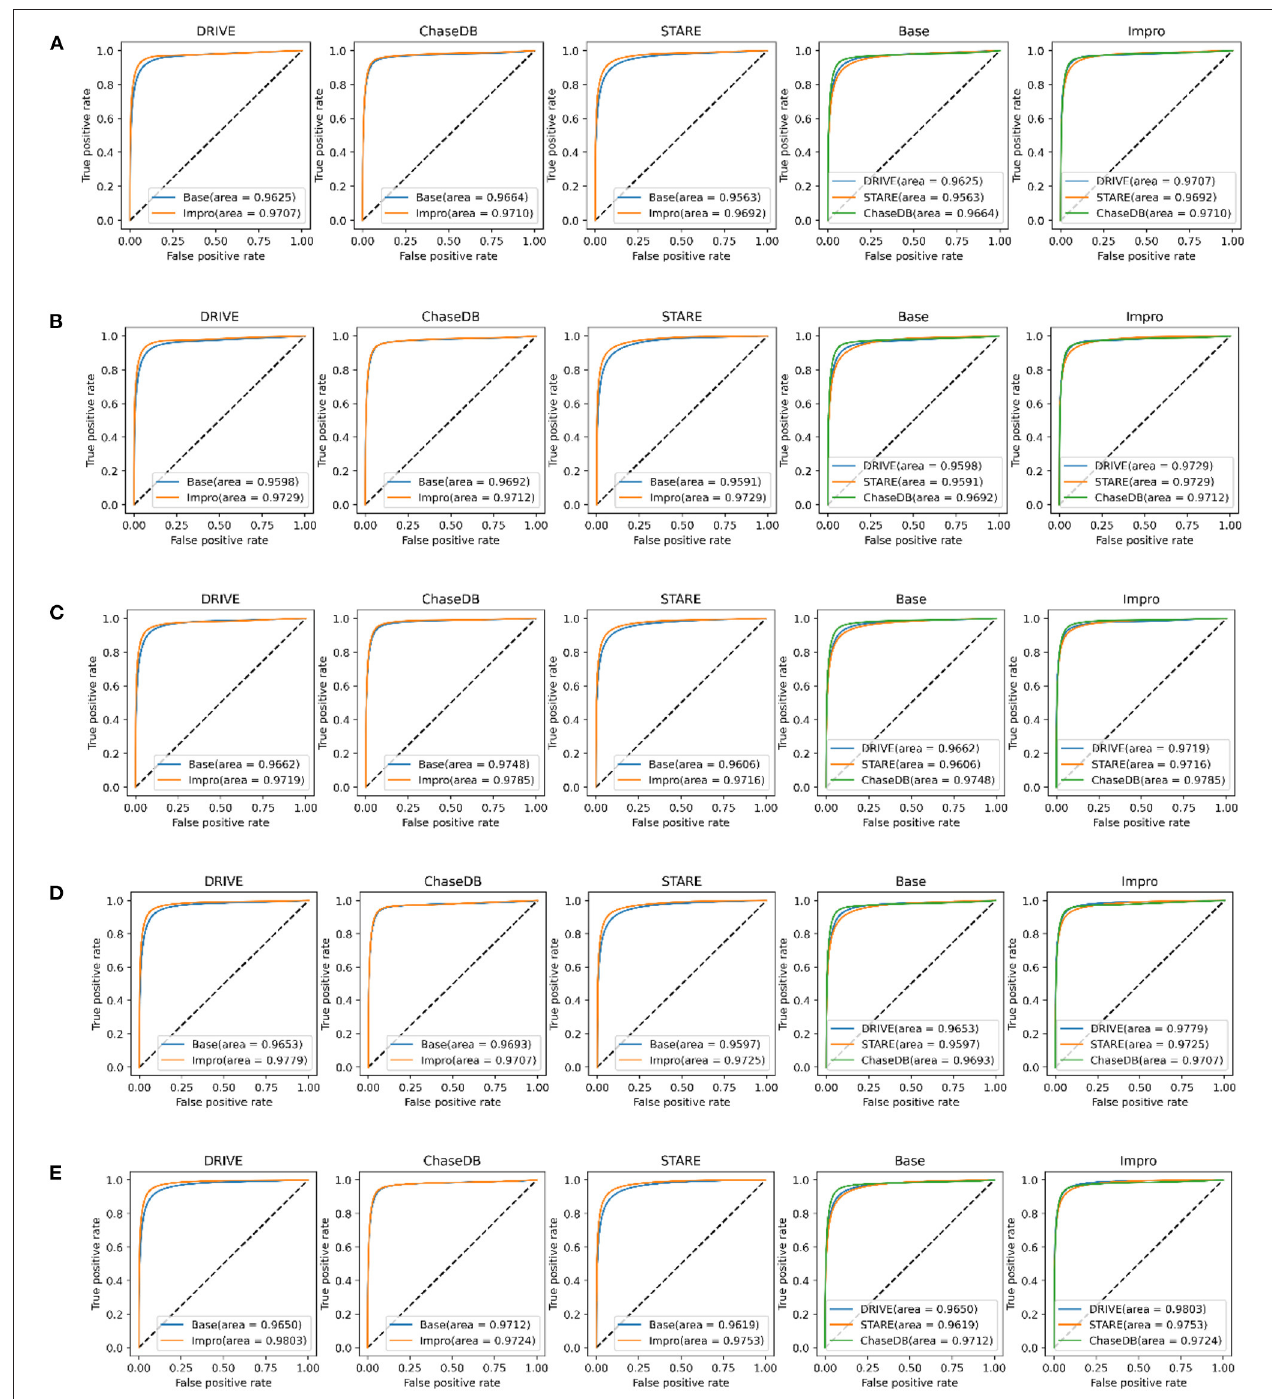
FIGURE 7 | Comparison of the baseline and upgraded models based on the AUC: (A) 5-way 3-shot; (B) 4-way 3-shot; (C) 3-way 3-shot; (D) 3-way 4-shot; and (E) 3-way 5-shot.